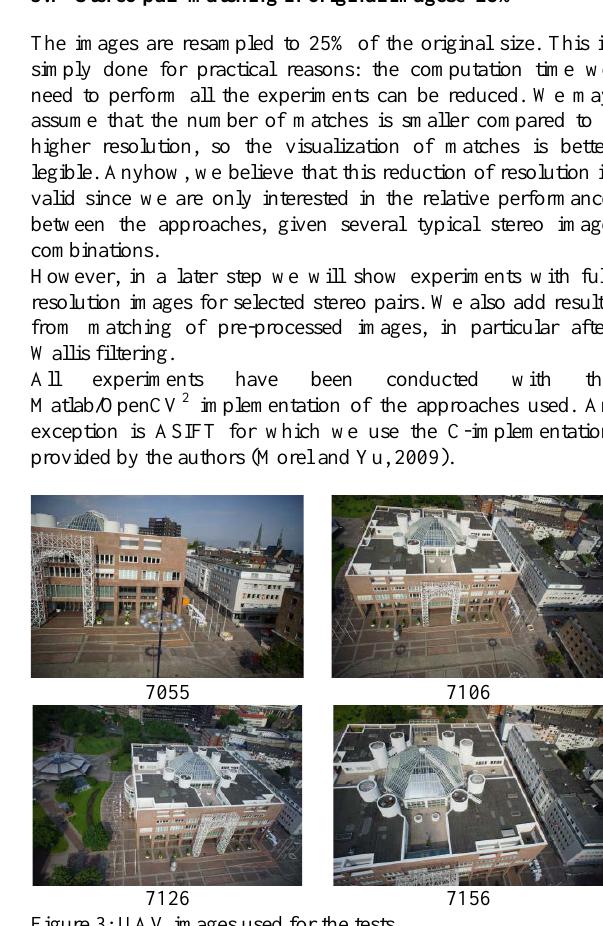
Figure 2: Terrestrial images used for the tests 3.1 Stereo pair matching in original images@25%